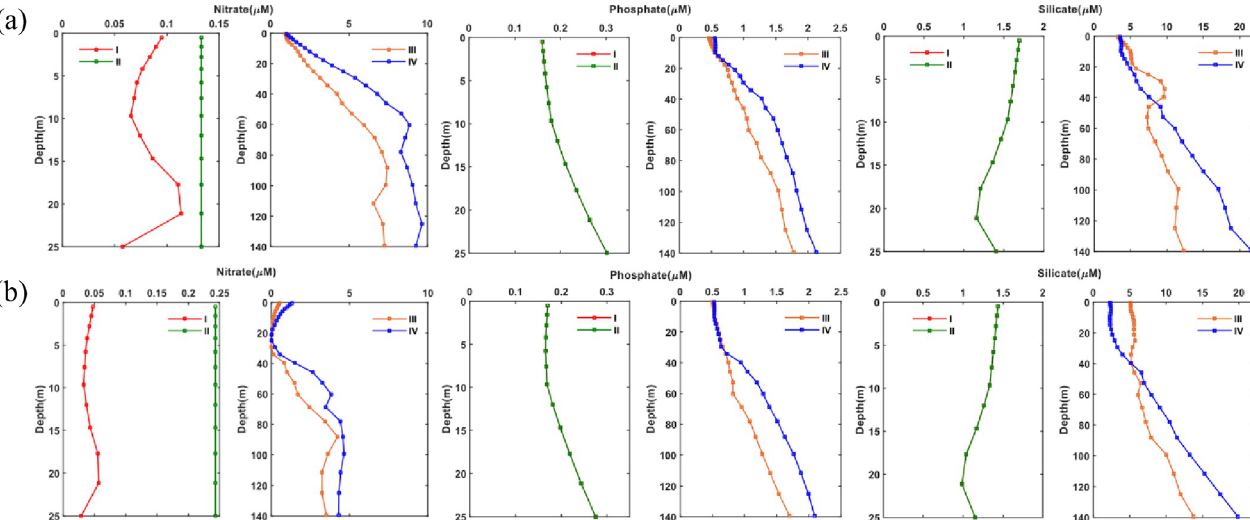
Fig 11. Nutrients (nitrate, phosphate, and silicate) profile at the upwelled waters from the surface up to a depth of 25 m at I and II and depth of 140 at III and IV extracted from the monthly climatology of the World Ocean Atlas data (WOA) for the year 2018. The WOA data are climatological data collected from the periods 1900–2017. Left: Nitrate, middle: Phosphate and right: Silicate. a): Summer (June, July, August); b): Winter (December, January,